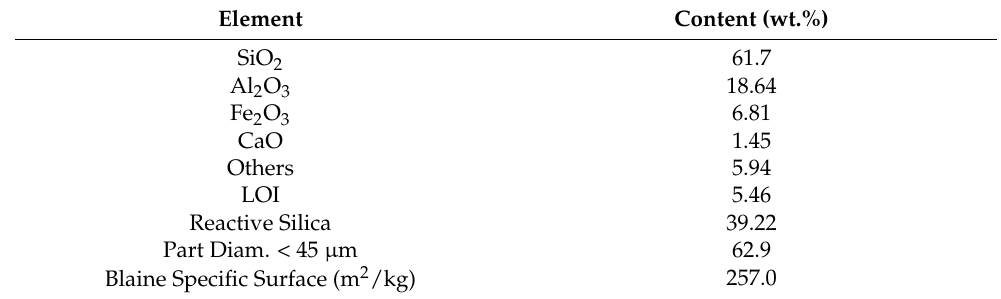
Table 1. Main fly ash